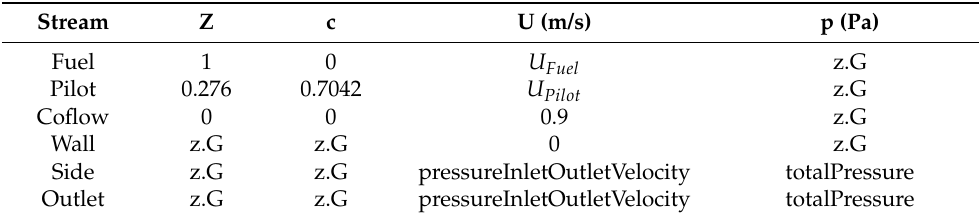
Table 2. Flame D and E boundary conditions. z.G stands for zero-gradient.